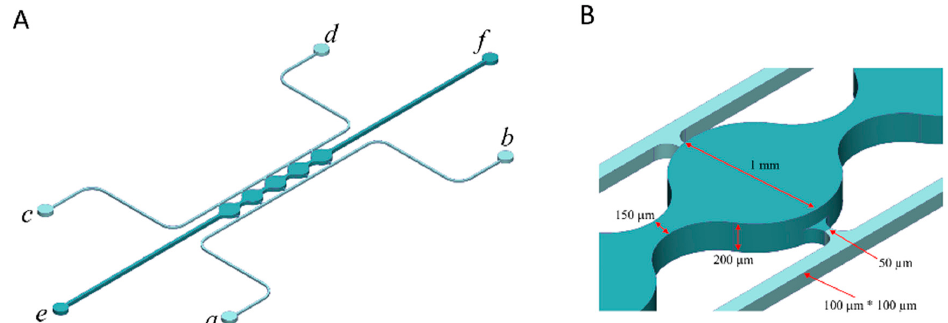
Figure 1. Microfluidic system design and assembly. ( A ) Microfluidic device consists of 5 cell culture chambers ( e – f ) flanked by two fluidic channels (port a–b , c–d ). ( B ) Dimensions of the cell culture